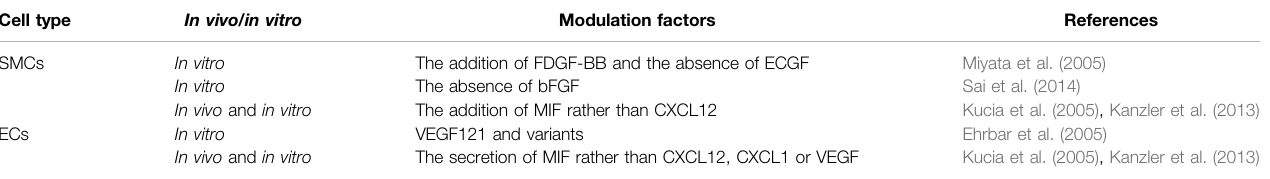
TABLE 2 | Modulation factors controlling EPCs differentiation into SMCs and